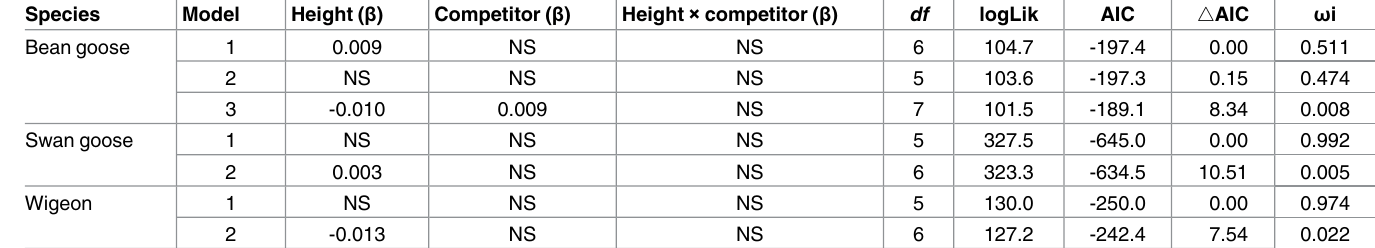
Table 4. Results of the best GLMMs to test whether the percentage vigilant time (arcsin transformed) was affected by sward height and competi- tors. In the model sward height, competitor and their interaction term were includedas fixed factors, whereas session, enclosurenumber, and individual were always includedas random factors in all models. NS indicatesthat the parameter was not includedin the model. All models with 4 AIC < 2, and the next best model are reported (AIC = Akaike Information Criterion. df ; logLik, 4 AIC = AIC(i)—AIC(min); ω i = Akaike weights). Species